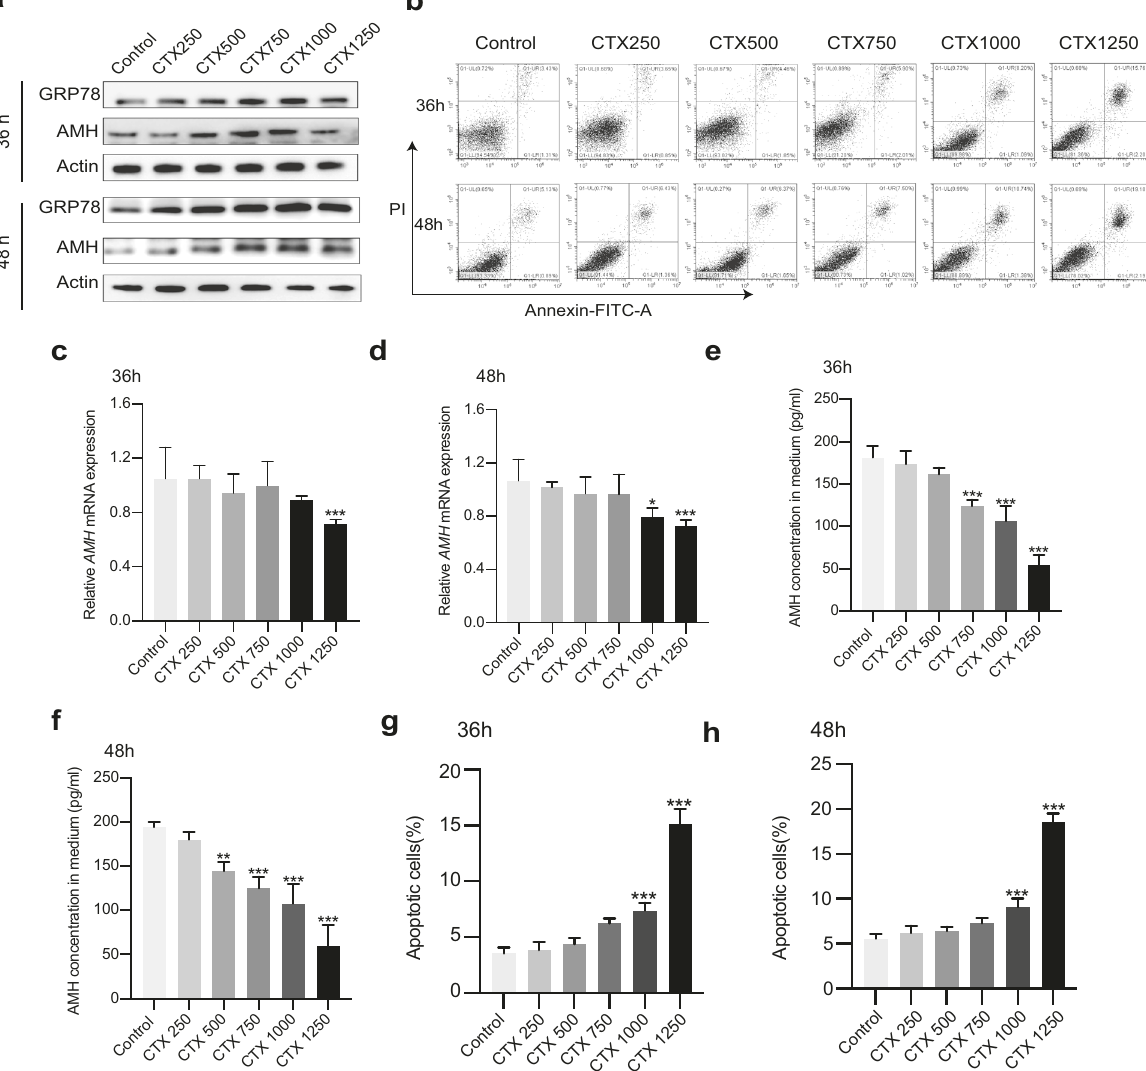
Fig. 3 Cyclophosphamide inhibits AMH secretion in vitro. a Representative western blot analysis of GRP78 and AMH from KGN cells at 36 h and 48 h after injection of vehicle or CTX at doses of 250 – 1250 µg/mL. b Apoptosis assay of KGN cells 36 h and 48 h after injection of vehicle or CTX at doses of 250 – 1250 µg/mL. Compared with untreated control cells, the level of apoptosis was signi fi cantly higher with ≥ 750 µg/mL CTX. c , d AMH mRNA levels of KGN cells veri fi ed by qPCR. e , f The concentration of AMH in the cell-culture medium declined as the CTX dose increased. g , h One-way ANOVA analysis of apoptotic cells displayed on b. All error bars represent the standard error of the mean. * P < 0.05, ** P < 0.001, and *** P <